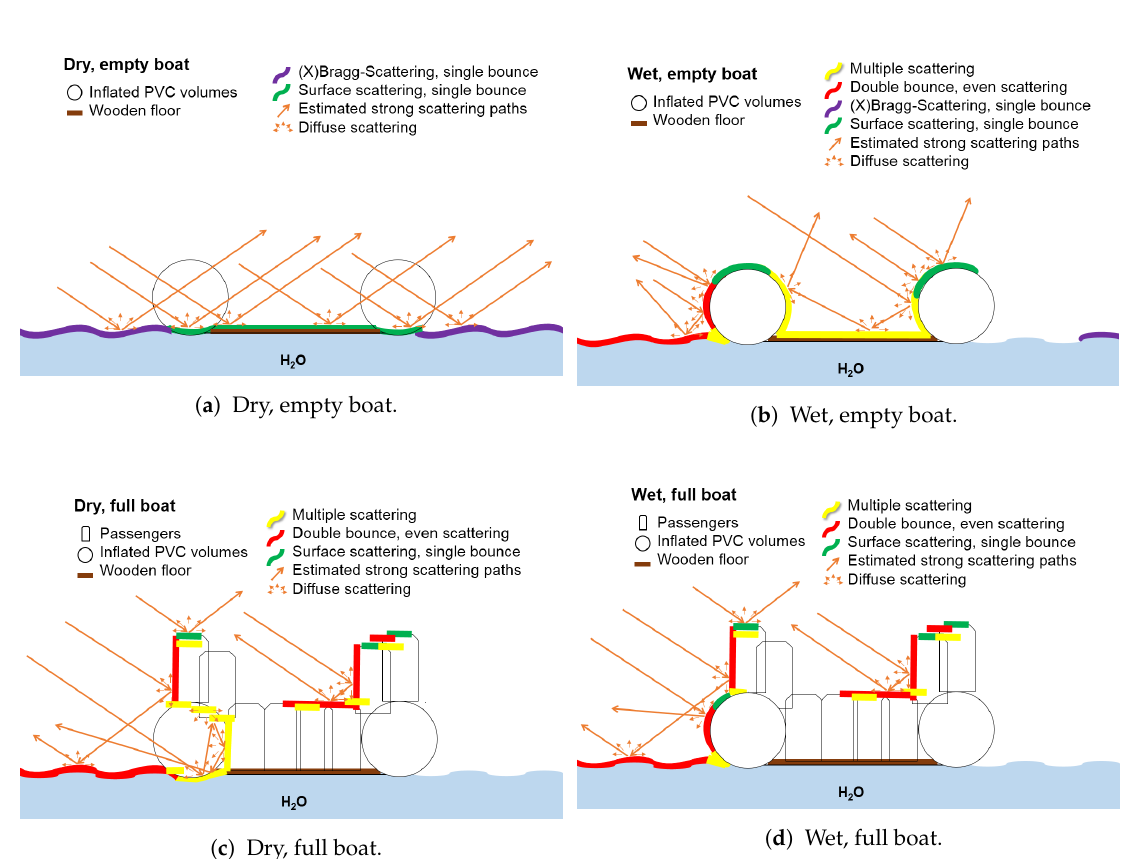
Figure 2. Expected scattering mechanisms of the vessel depending on wetness and